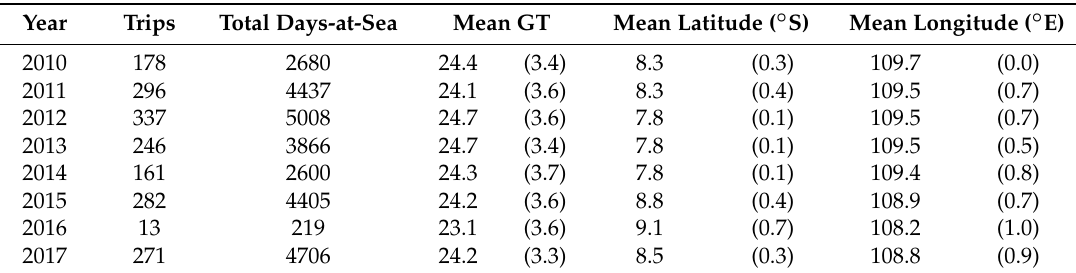
Table 1. Trip summary of coastal gillnet fishery during 2010–2017. Results are pooled and also presented by year of observation. Operational parameters are means and standard deviations (inside parentheses). GT: gross tonnage.